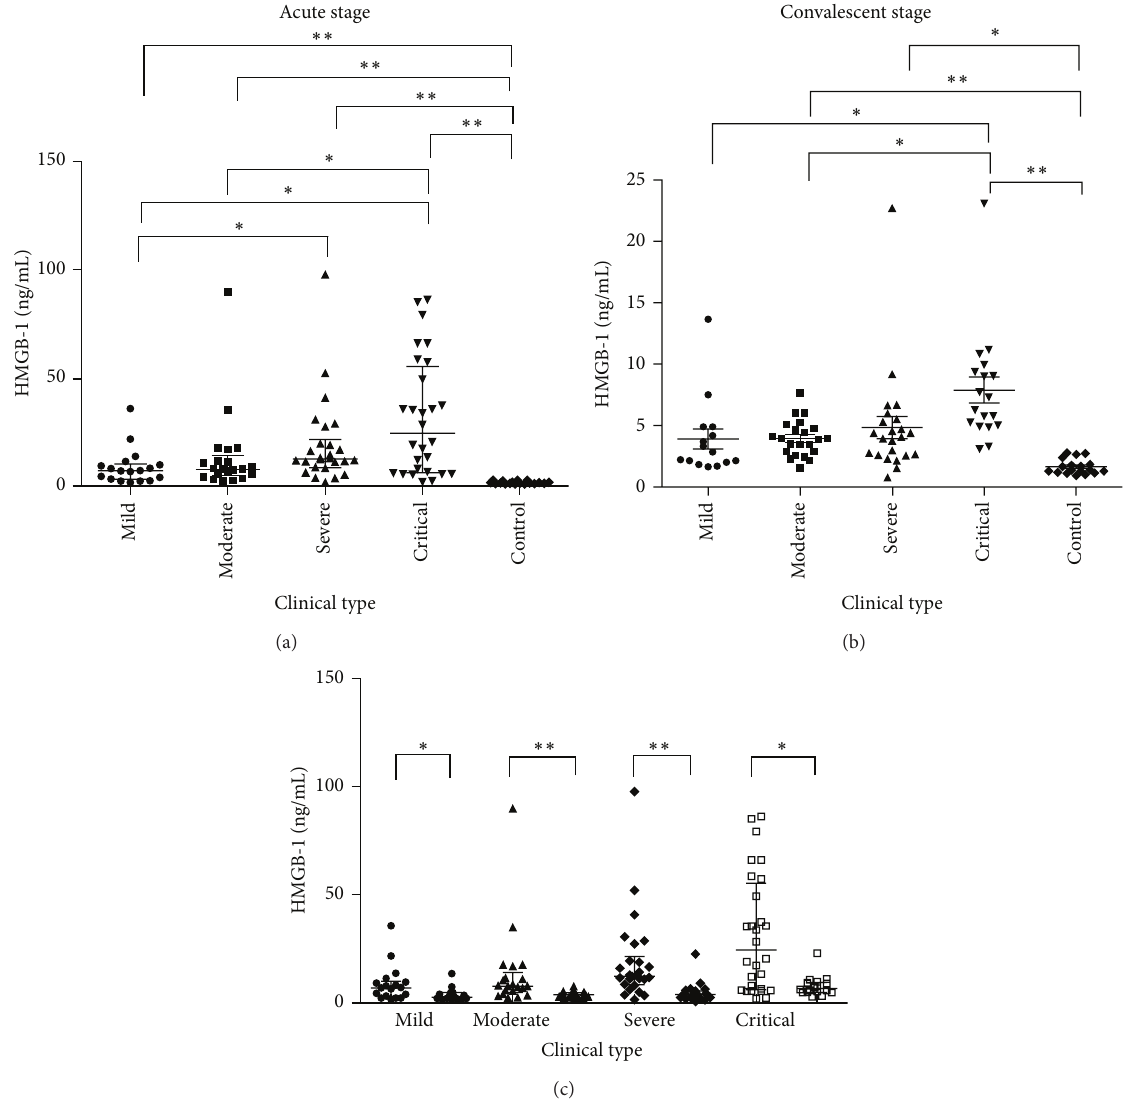
Figure 1: Levels of HMGB-1 during the clinical course in patients with HFRS. The concentrations of HMGB-1 were presented as medians with IQR and were compared by the Nemenyi Rank test among the five groups ((a) and (b)). The concentrations of HMGB-1 were presented as medians with IQR and were compared by a Mann-Whitney 𝑈 test for the acute stage and convalescent stage (c). ∗ 𝑃 < 0.05 ; ∗∗ 𝑃 < 0.001 .